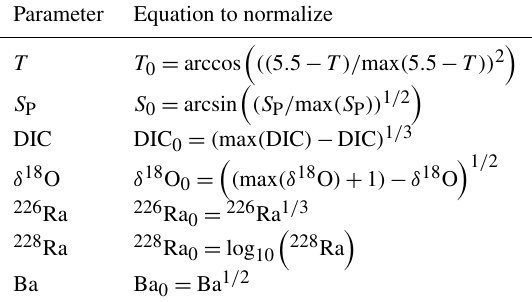
Table A1. Equations used to normalize ( X 0 ) the data distribu- tion for temperature ( T ), practical salinity ( S P ), dissolved in- organic carbon (DIC, µmolkg − 1 ), δ 18 O, 226 Ra (dpm100L − 1 ), 228 Ra (dpm100L − 1 ), and Ba (nM) collected throughout the CAA 2015 GEOTRACES cruise in preparation for principal component